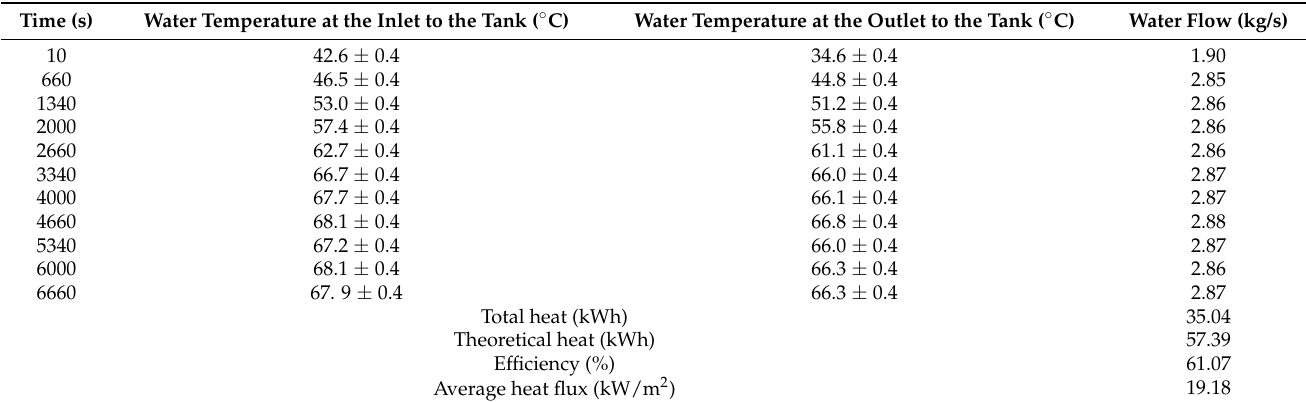
Table 3. Process of heat storage